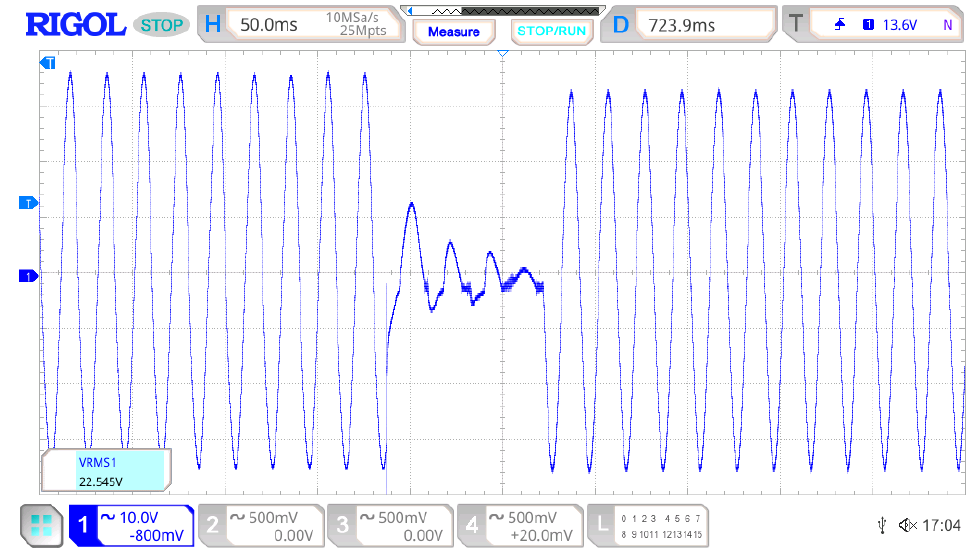
Figure 14. The transition from grid synchronization mode to islanded mode with